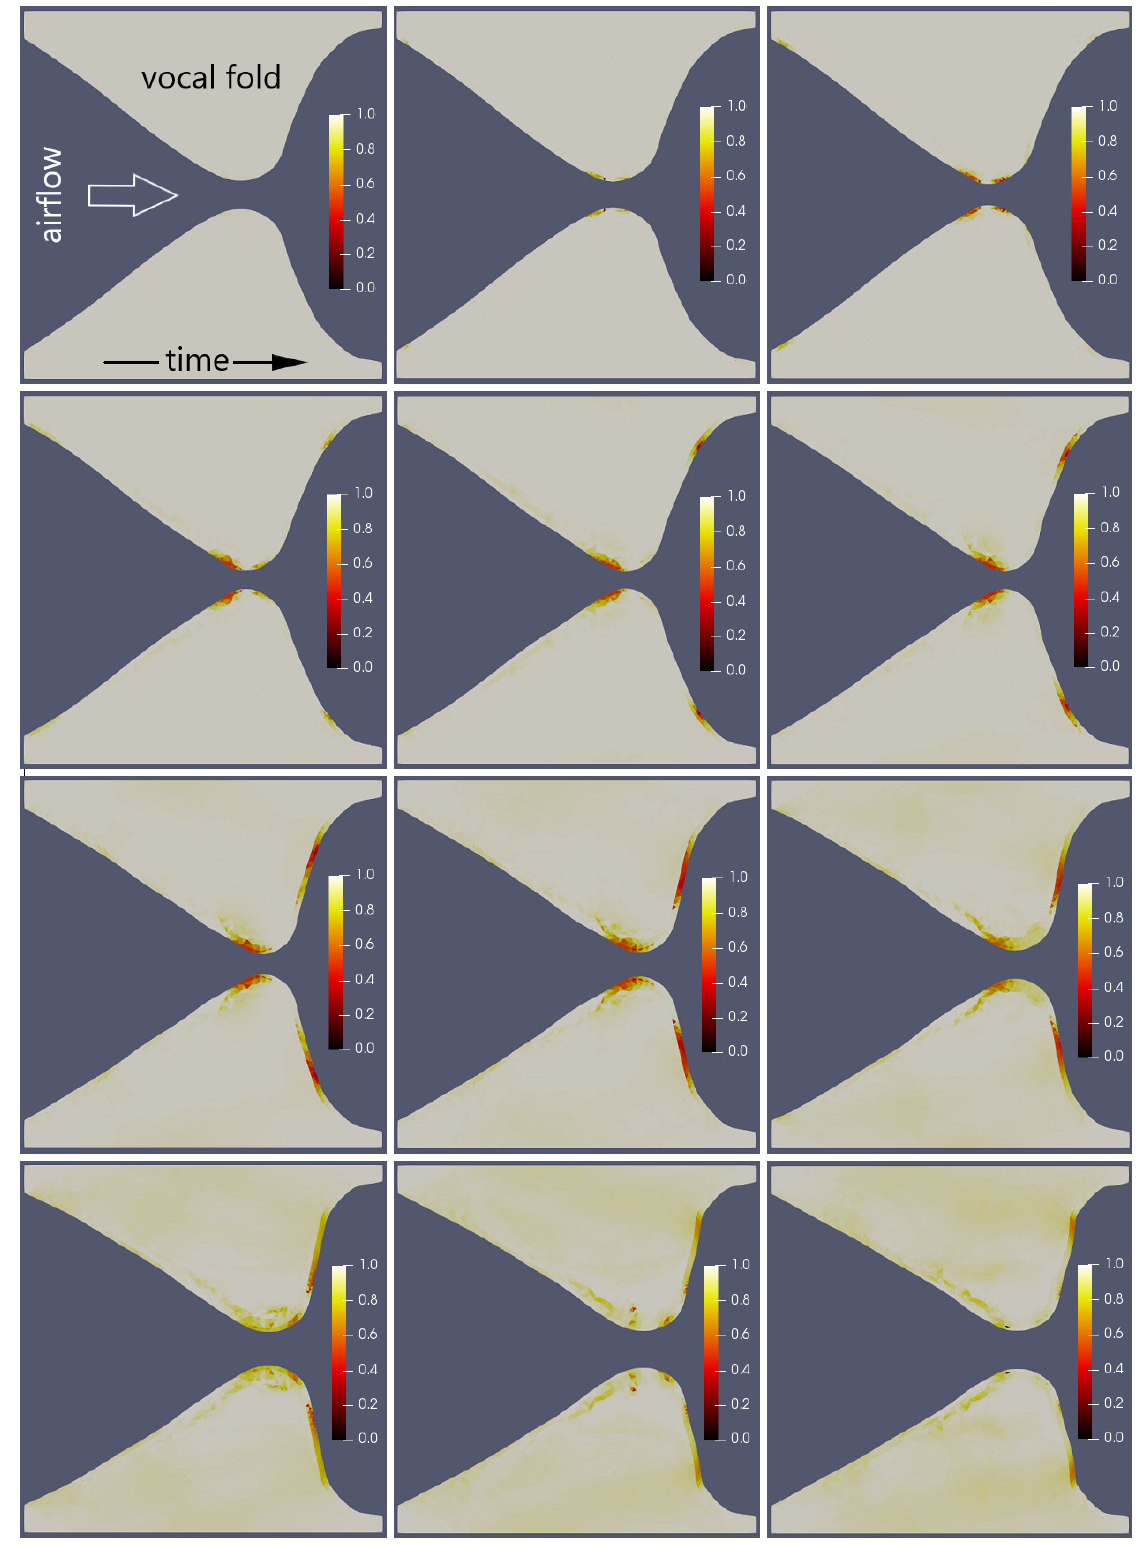
Figure 12. Visualization of the VFs vibrations and the ratios R of the norms of linear and nonlinear strain tensors at twelve time instants. Computed by the St. Venant–Kirchhoff elasticity